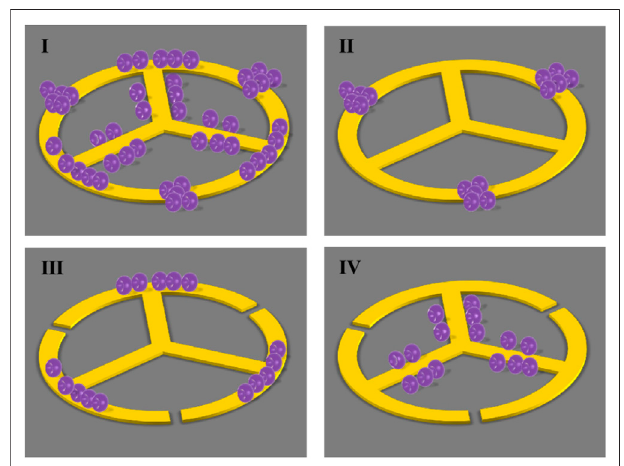
FIGURE 4 | Four cases of analytes gathering on the surface of MM